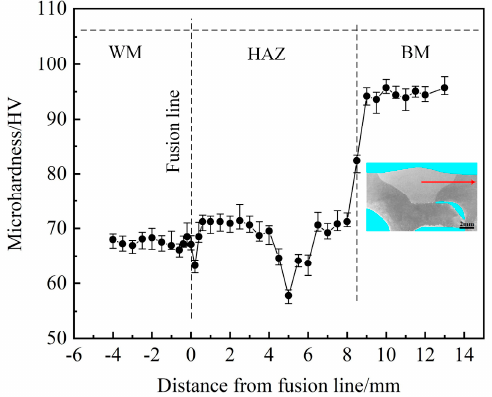
Figure 6. Microhardness distribution of the joint.